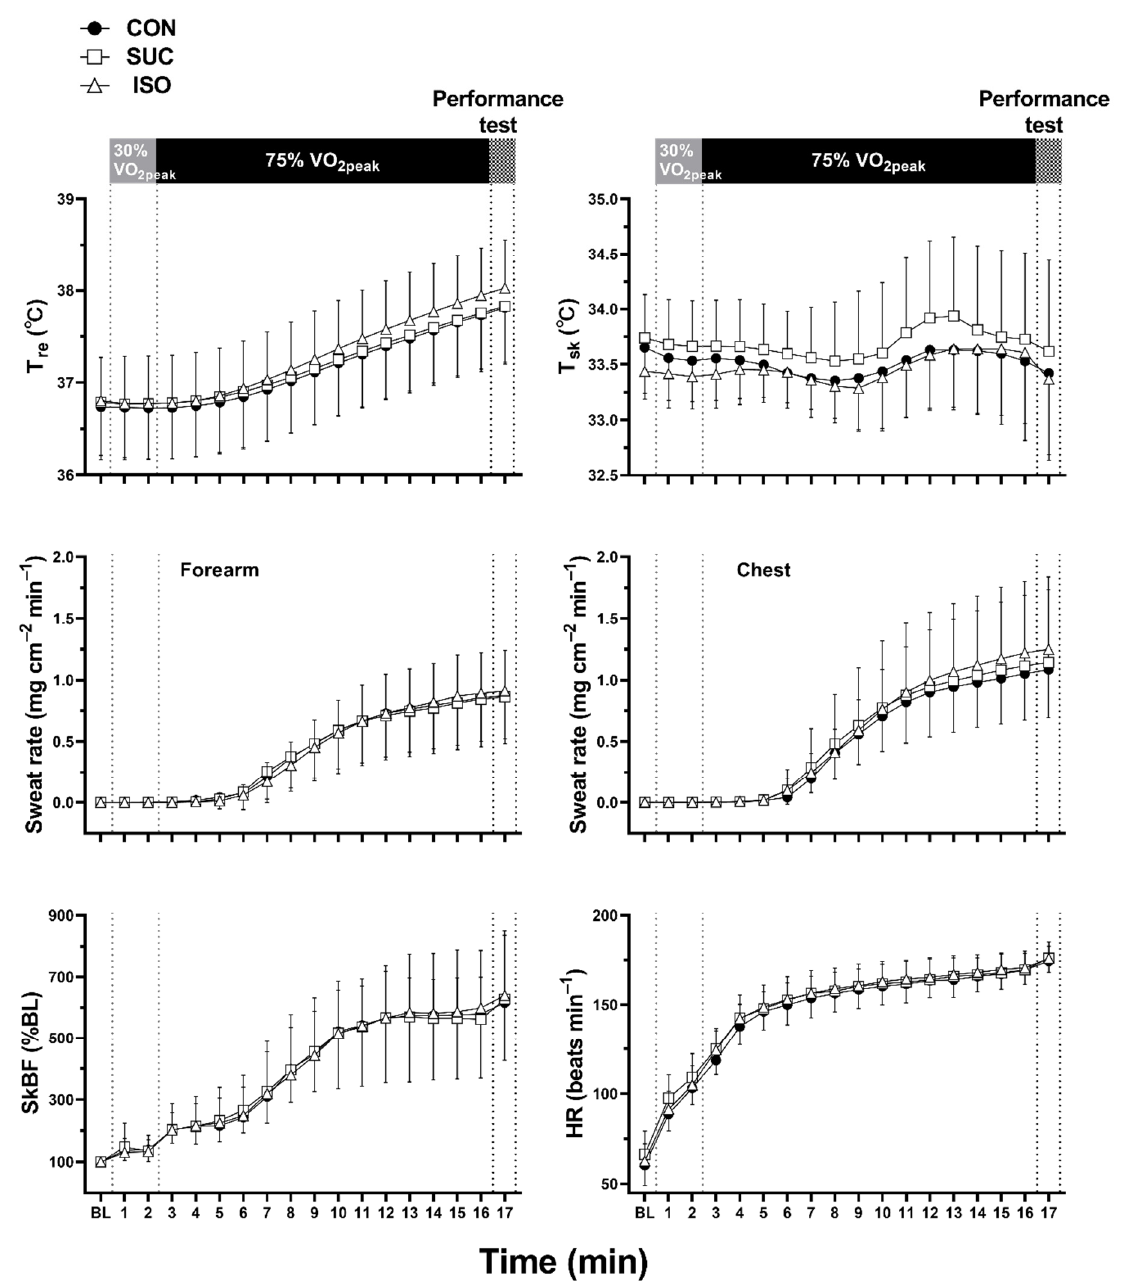
Figure 4. Rectal temperature (T re , n = 9), mean skin temperature (T sk , n = 9), sweat rate on the forearm and chest, skin blood flow (SkBF) on the chest, and heart rate (HR) during exercise. CON, control (water); SUC, sucrose; ISO, isomaltulose; BL, baseline. Values are presented as mean ± SD. n = 10, unless otherwise indicated.